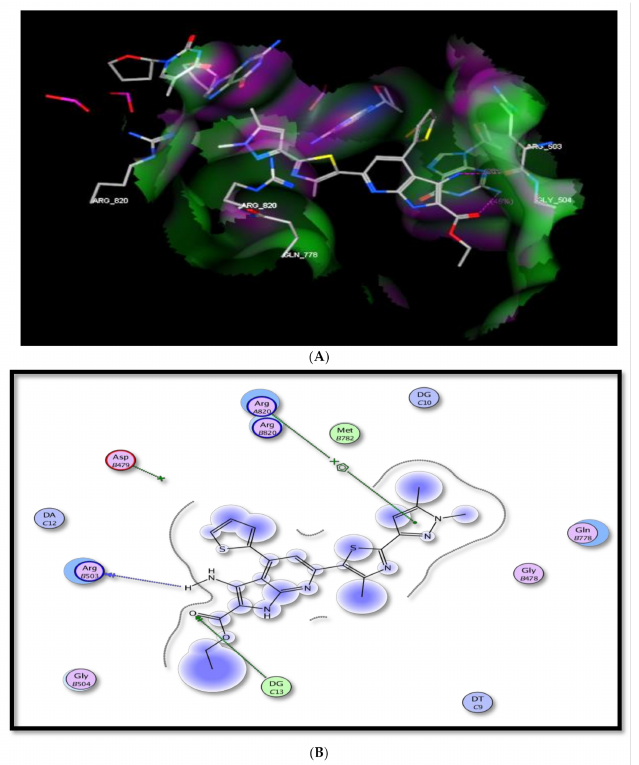
Figure 8. The suggested binding mode of compound 10 within topoisomerase II. ( A ) 3D binding mode within the active site. ( B ) 2D binding mode within topoisomerase II.